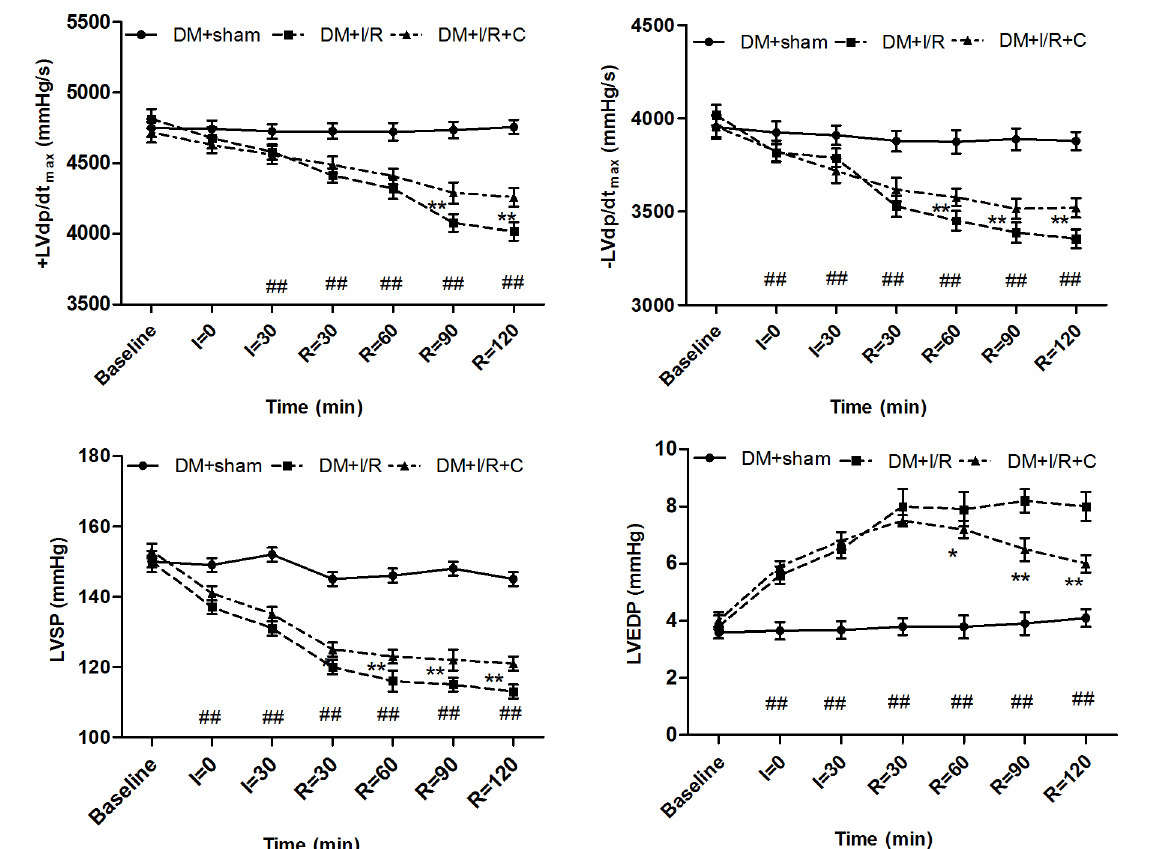
Figure 4. Effects of catalpol on cardiac function. ## P < 0.01 versus the DM+sham group; * P < 0.05 versus the DM+I/R group; ** P < 0.01 versus the DM+I/R